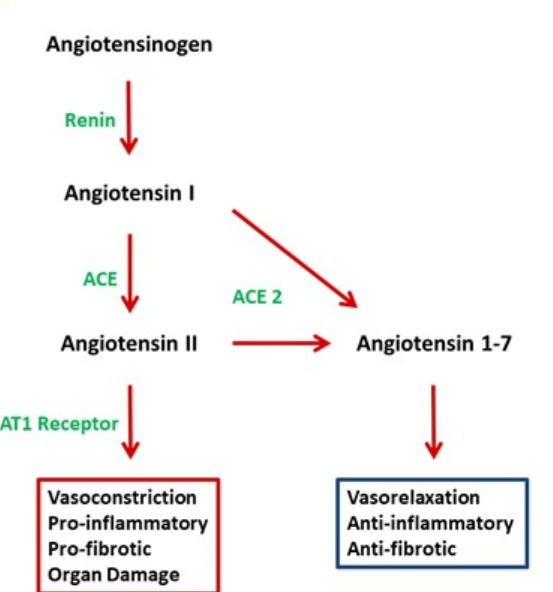
Figure 2. The renin-angiotensin system (RAS) with the two different axes, the classical one with the effector peptide Angiotensin II and the new one with the effector peptide Angiotensin 1–7.